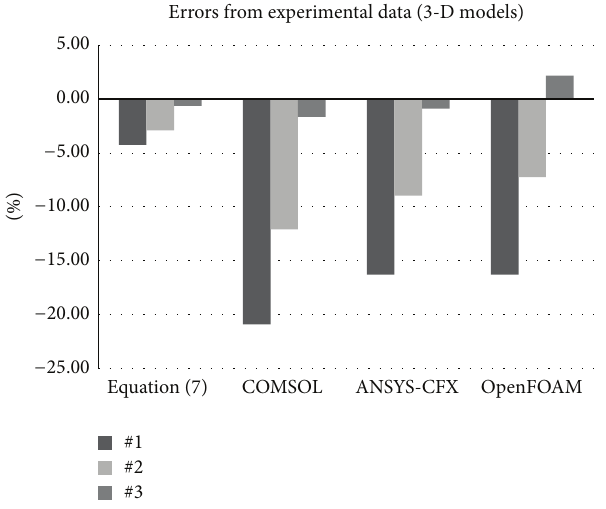
Figure 11: Comparison of relative errors for various 3D codes from the experimental data.